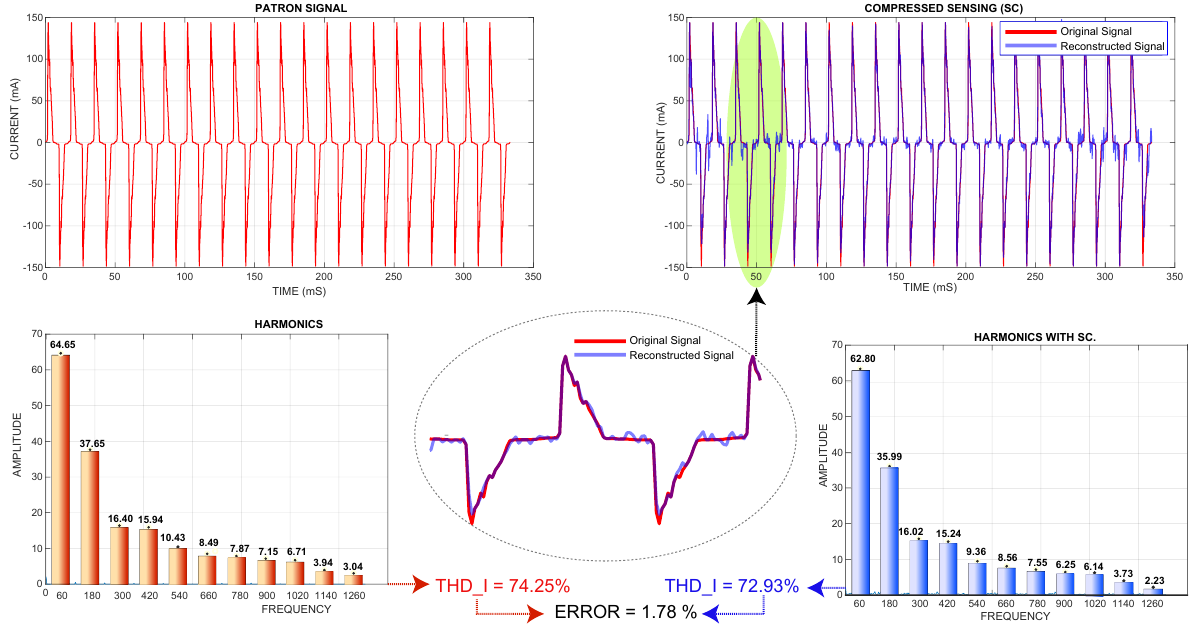
Figure 15. Real signal and its harmonics vs. CS-reconstructed signal and its harmonics. This article contributes to the localization of current harmonic distortion in a nonlinear load, the hardware. It was analyzed how the signal reconstruction error affects the THD error found by compressed sensing compared to the TDH measured by the standard measurement equipment. Figure 16 was physically implemented, and the measurements obtained were compared with the measurements of the standard measurement